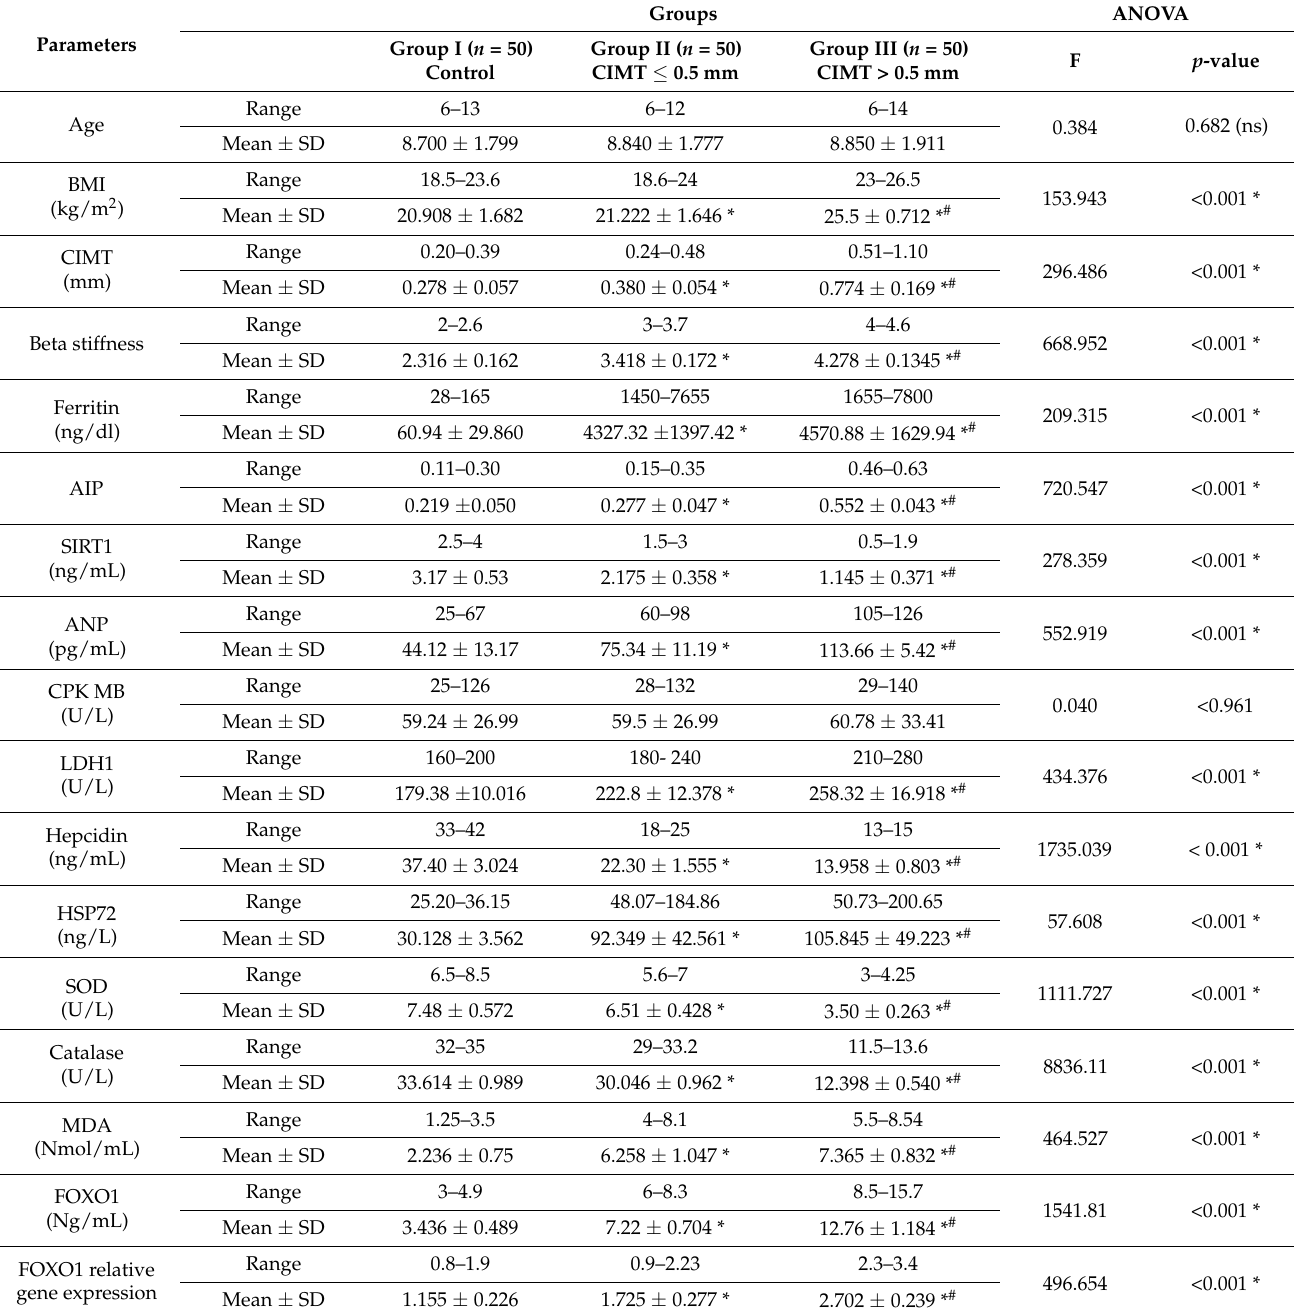
Table 1. Statistical comparisons among all the studied groups as regards all the studied